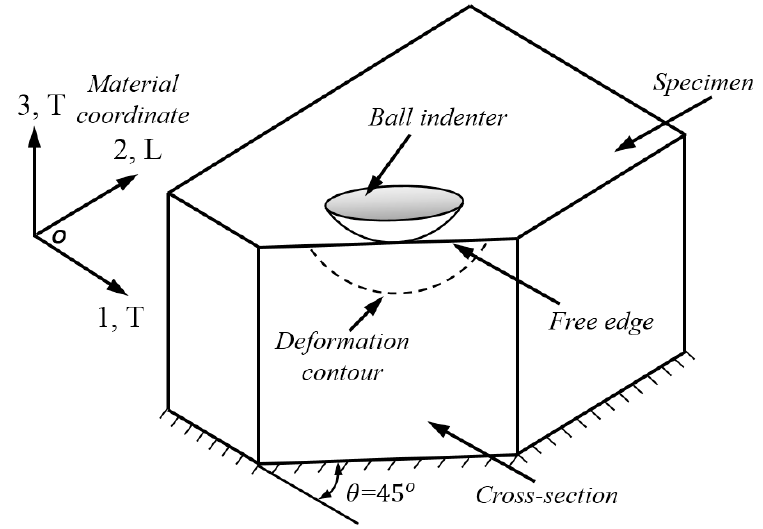
Figure 3. Schematic of the cross-sectional indentation model.